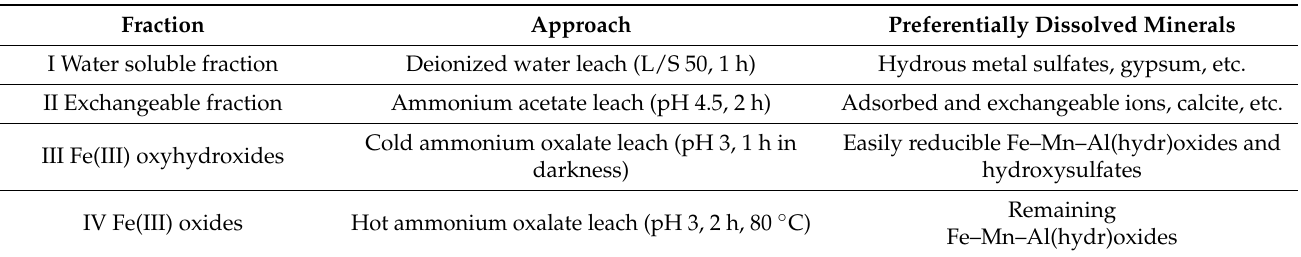
Table 1. Sequential extraction according to Dold (2003) adopted to copper-sulfide mine waste with the minerals preferentially dissolved in each